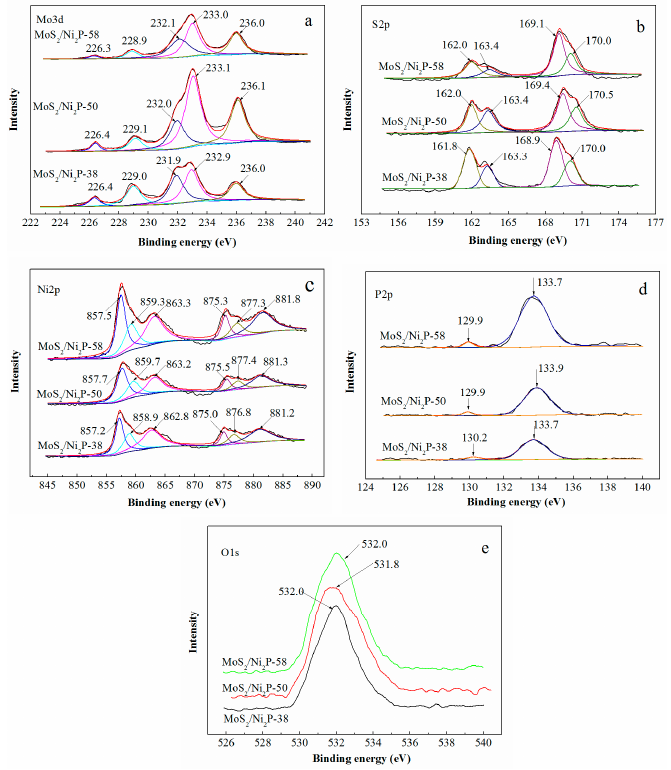
Figure 3. XPS spectra of three MoS 2 /Ni 2 P hybrids: ( a ) Mo 3d; ( b ) S 2p; ( c ) Ni 2p; ( d ) P 2p; and ( e ) O 1s.